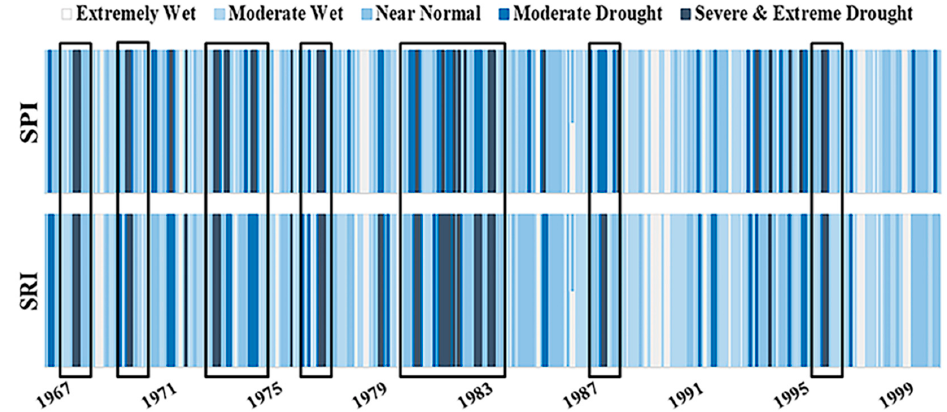
Figure 3. Temporal evolution of the SPI and SRI during 1967–2000 at the sub-basin #1003, and an example of propagation of drought classes from SPI to SRI.